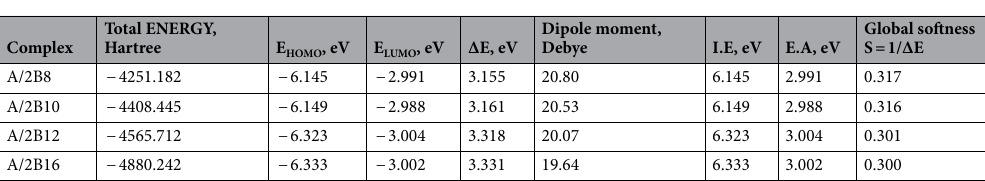
Table 2. Total Energy , E HOMO , E LUMO , ∆E, dipole moment, ionization energy, electron affinity and softness parameter calculated at B3LYP/6-31 g(d,p) level for the H-bonded complexes, A/2Bn. E HOMO energy of the highest occupied molecular orbital, E LUMO energy of the lowest unoccupied molecular orbital and ∆E = E LUMO − E HOMO ; orbital energy